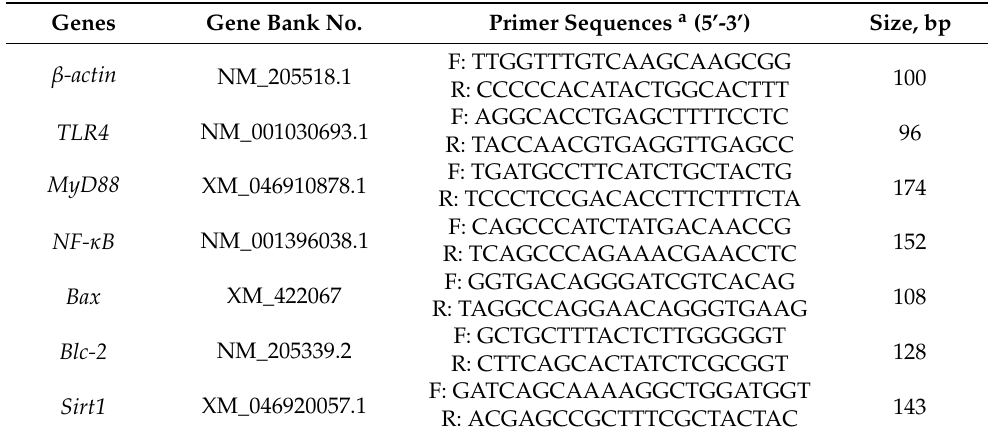
Table 2. Primer sequences used for quantitative real-time PCR. Genes Gene Bank